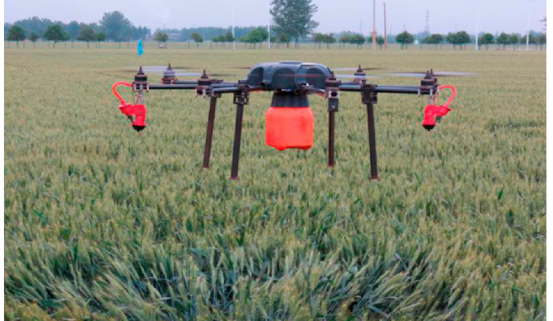
Figure 1. Image of an unmanned aerial vehicle (retrieved from Wang et al.